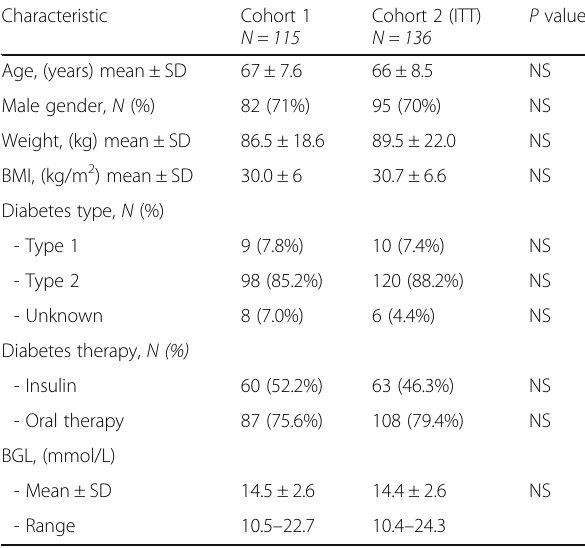
Table 1 Baseline characteristics comparison between Cohort 1 and Cohort 2 (overall ITT group)